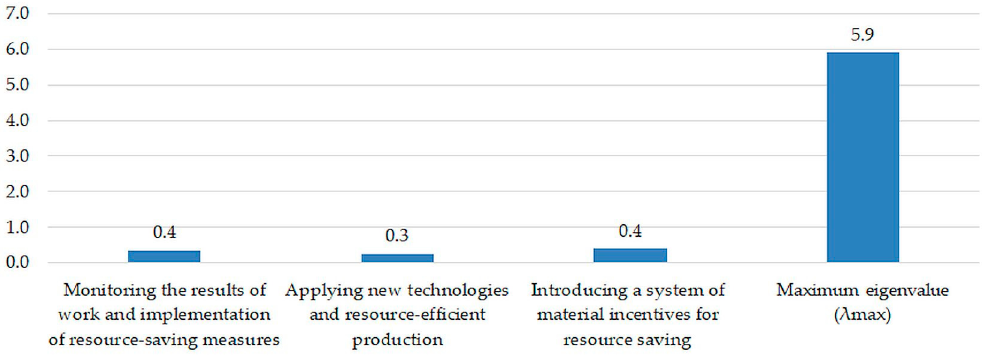
Figure 6. Degree of influence of the “Improving the organization of work to improve resource efficiency and resource conservation” block at the “Factors” level. The degree of influence at the “Actors’ Targets” level was determined using a matrix of